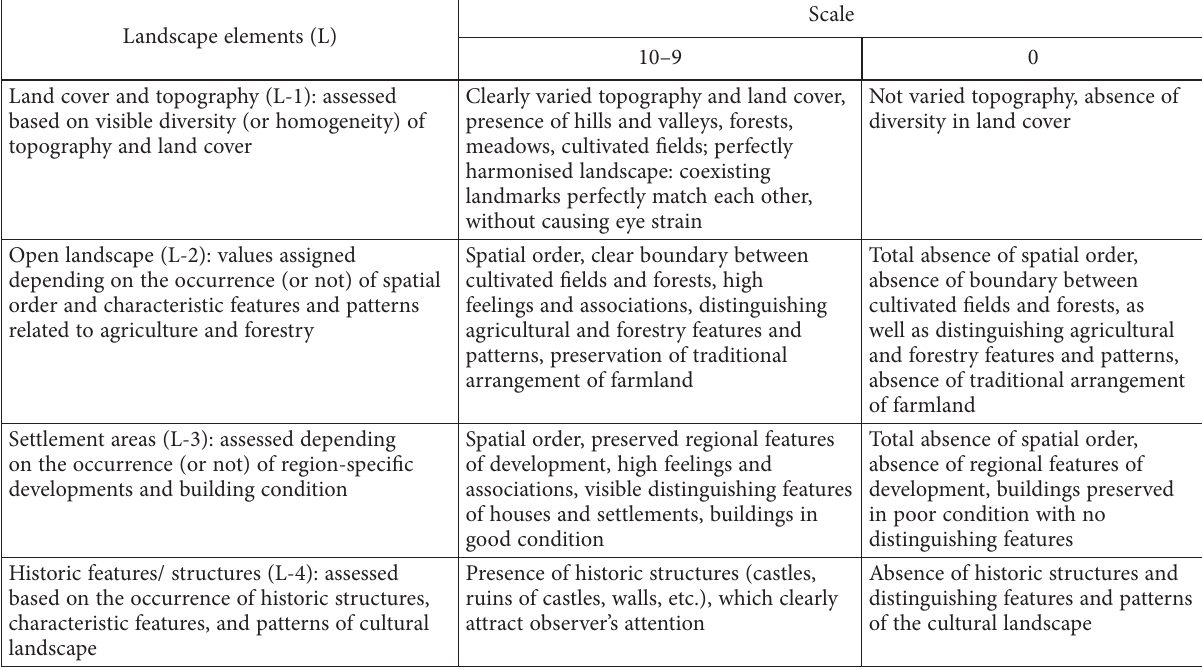
Table 2. Extreme values of landscape elements as per the LSHM Method (source: author’s study) Landscape elements